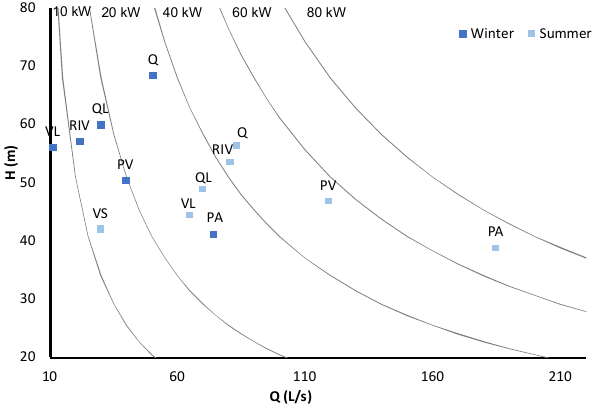
Figure 4. Results from preliminary energy recovery assessment.